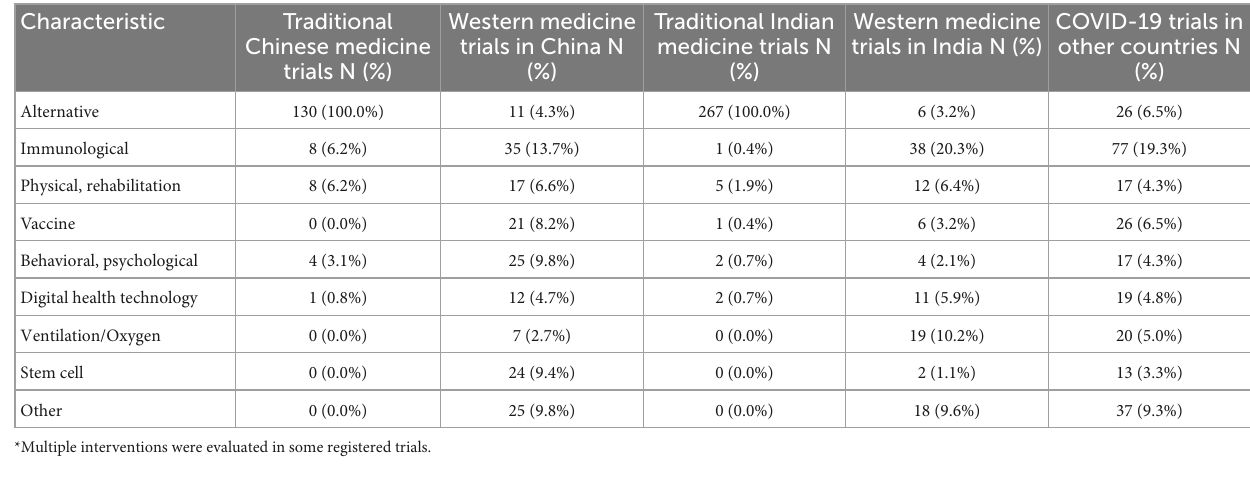
TABLE 2 Types of result reporting of registered COVID-19 clinical